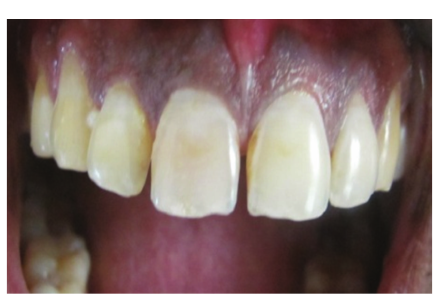
Figure 13: Diagnostic